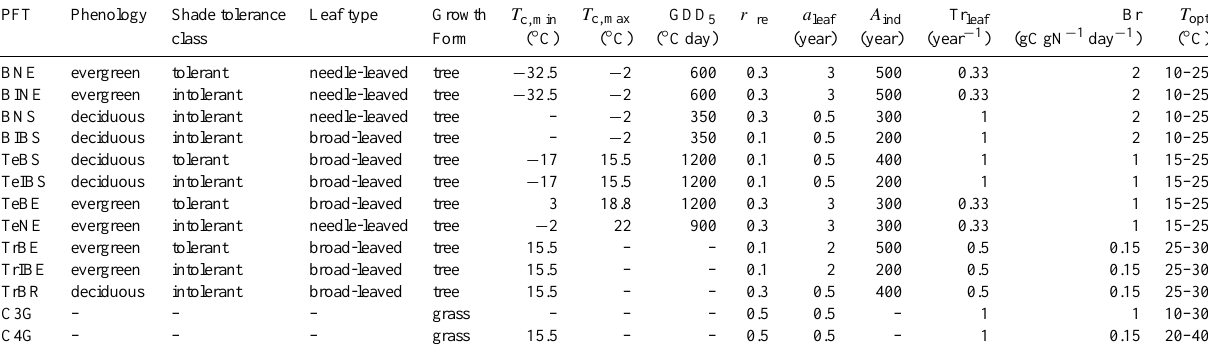
Table A1. PFT characteristics and parameter values used in this study. T c,min = minimum coldest-month temperature for survival and establishment; T c,max = maximum coldest-month temperature for establishment; GDD 5 = minimum accumulated degree-day sum of days above 5 ◦ C for establishment; r fire = fraction of individuals surviving fire; a leaf = leaf longevity; a ind = individual maximum, non-stressed longevity; Tr leaf = leaf turnover rate; Br = base respiration rate at 10 ◦ C; T opt = optimal temperature range for photosynthesis. Full PFT names: BNE = boreal needle-leaved evergreen tree; BINE = boreal shade intolerant needle-leaved evergreen tree; BNS = boreal needle- leaved summergreen tree; BIBS = boreal shade intolerant broad-leaved summergreen tree; TeBS = temperate broad-leaved summergreen tree; TeIBS = temperate shade intolerant broad-leaved summergreen tree; TeBE = temperate broad-leaved evergreen tree; TeNE = temperate needle-leaved evergreen tree; TrBE = tropical broad-leaved evergreen tree; TrIBE = tropical shade intolerant broad-leaved evergreen tree; TrBR = tropical broad-leaved raingreen tree; C3G = C 3 grass; C4G = C 4